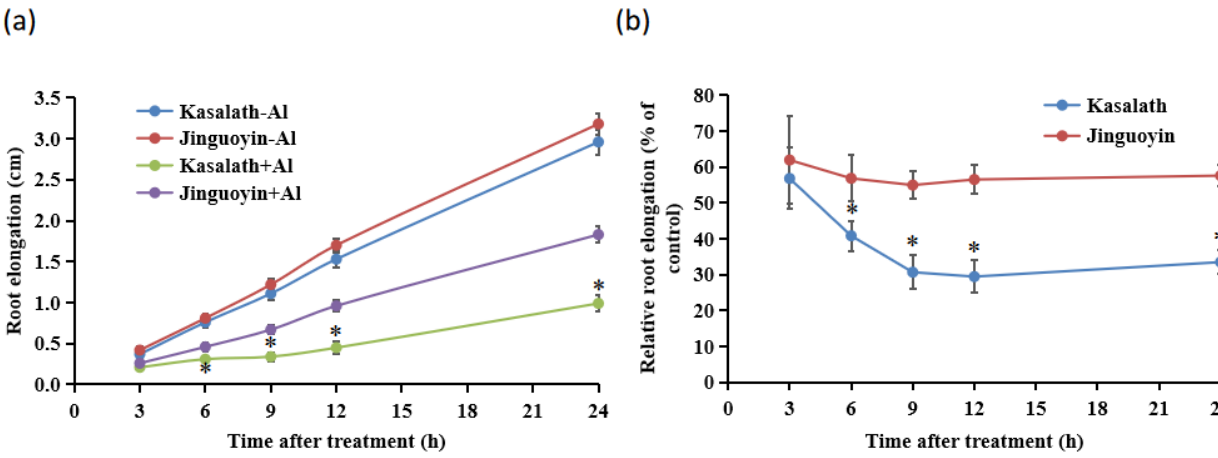
Figure 2. Time-dependent root elongation in two indica rice cultivars with and without Al. Absolute root elongation ( a ); relative root elongation ( b ). Four-day-old seedlings of both Kasalath and Jinguoyin were exposed to a 0.5 mM CaCl 2 (pH 4.5) solution containing 0 or 50 µ M Al for up to 24 h. Root lengths were measured with a ruler at different time points. Data are mean ± SD (n = 10). Asterisks (*) indicate significant differences between Kasalath and Jinguoyin in the presence of Al at each time point at p -values <0.05 by the Student’s t -test.